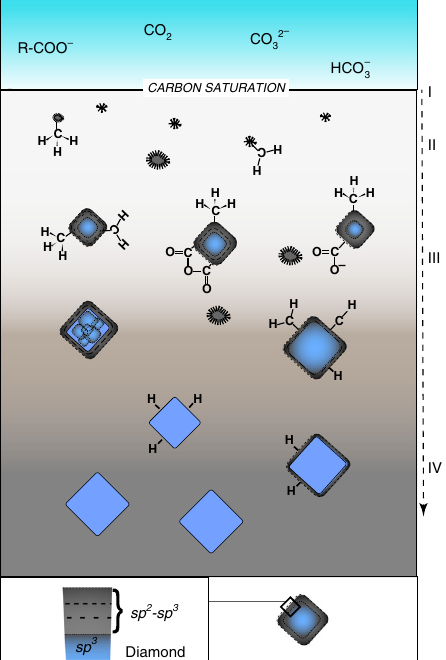
Fig. 4 Schematic formation pathway for diamonds from dissolved organic and inorganic carbon compounds in deep hydrous fl uids. (I) Carbon saturation ( C 0 ) on the reduction of carboxyl-containing groups from dissolved organic acids and formation of disordered sp 2 -, sp 3 -bonded amorphous carbon as an intermediate state preceding the crystallization of diamond. (II) Early stages of nucleation of crystalline diamonds facilitated by tetrahedrally coordinated radical structural intermediates. (III) Further growth brings to nano-sized diamonds coated by disordered sp 2 carbon, and amorphous sp 2 , sp 3 carbon. Metastable diamond polytypes can also form. (IV) Crystalline microdiamonds with almost no sp 2